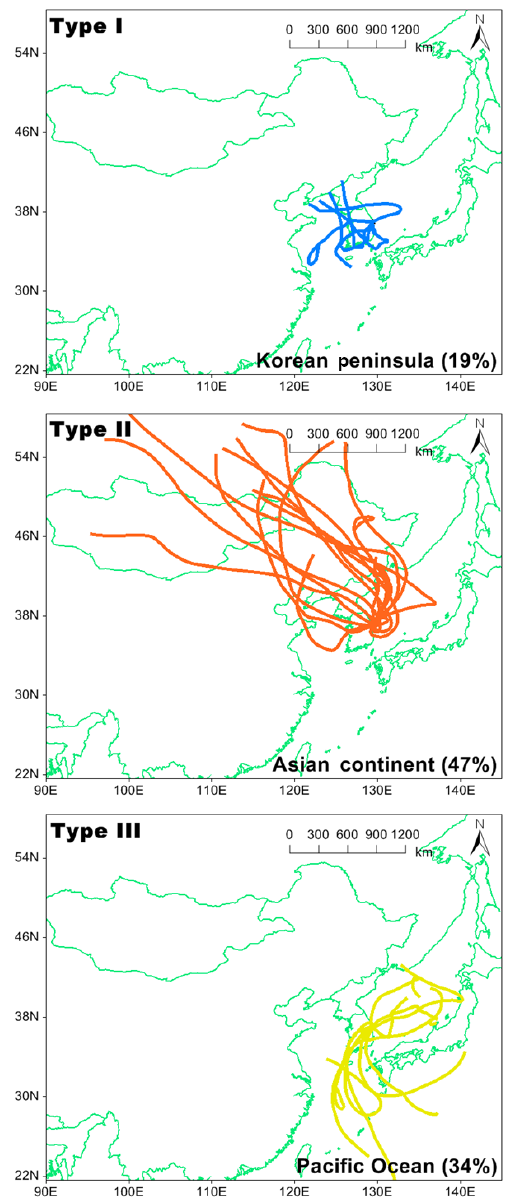
Figure 3. Three-day air-mass backward trajectories at 500 m (above ground level) for precipitation events at Uljin during the sampling period, obtained using the HYSPLIT model. The air-mass prove- nances are sorted into three groups: Korean Peninsula (type I), Asian continent (type II), and Pacific Ocean (type III). The percent- age values in parentheses indicate the occurring frequencies of each